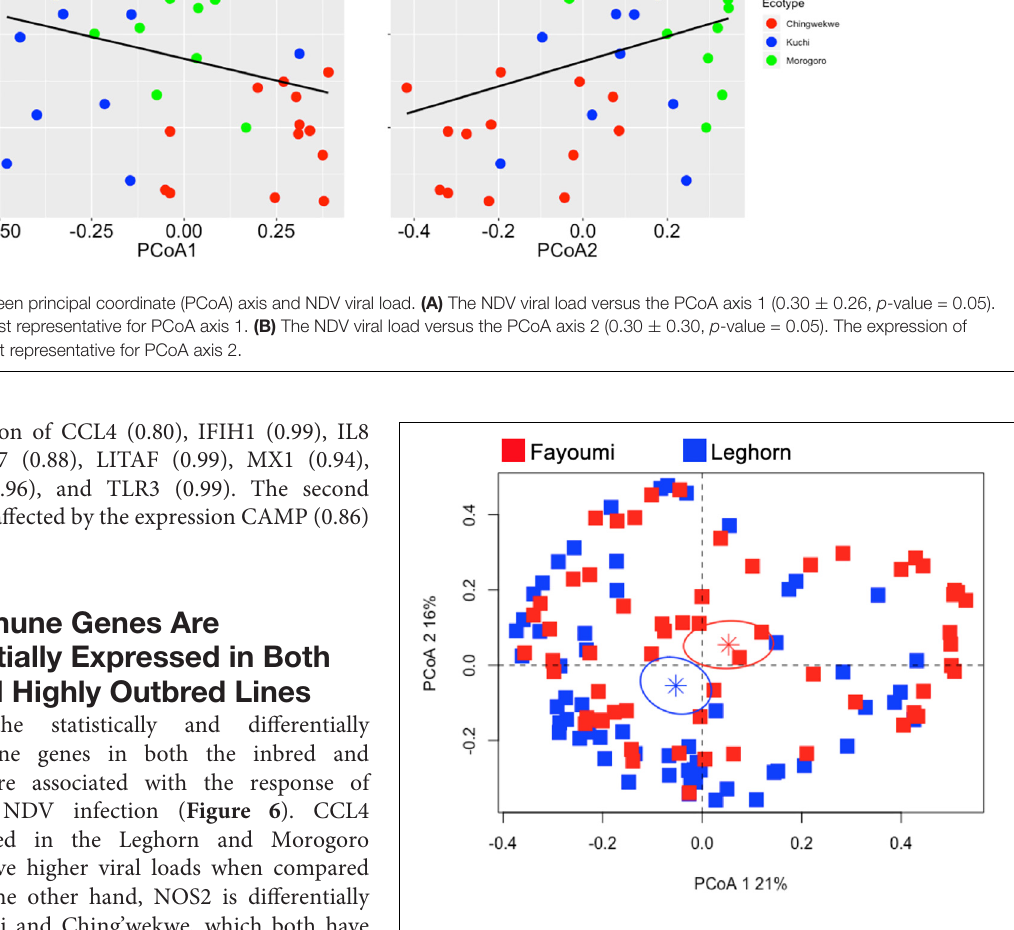
FIGURE 5 | Principal coordinate analysis of the gene expression profiles of the Fayoumi and Leghorn. The gene expression profiles from the previous study were filtered to only include the same genes examined in the outbred lines. The PCoA plot demonstrates clustering of each breed ( p -value < 0.01). The Fayoumi is represented by the red squares and the Leghorn by. The stars represent the average for each breed and the ellipse is the 95% confidence interval (in each respective